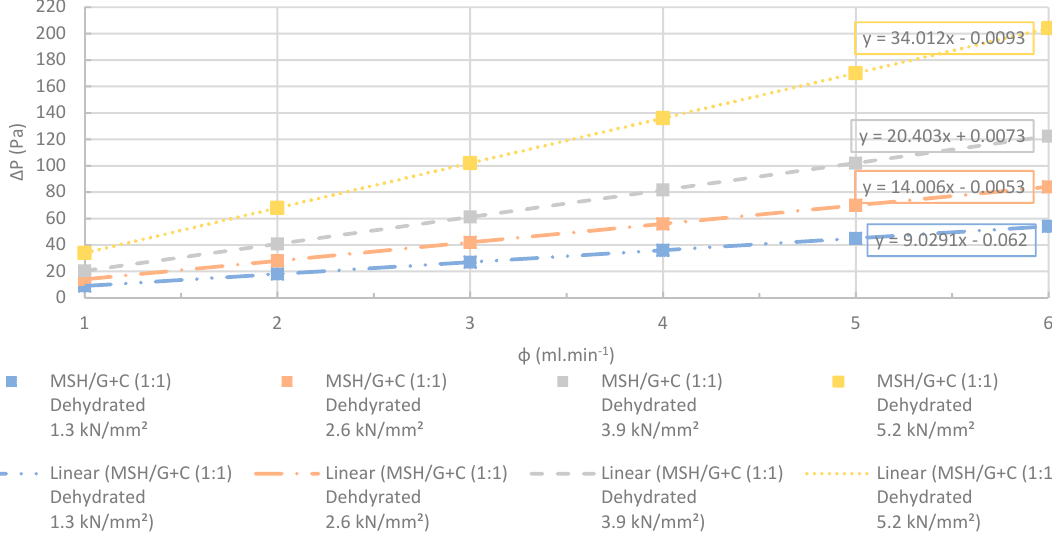
Figure 28. Changes at differential pressures with increasing flow rates. The MSH/G+C (1:1) pellets manufactured at several different compression pressures were dehydrated completely before the test. R 2 > 0.99. The accuracy of the pressure measurements was less than 0.1%.